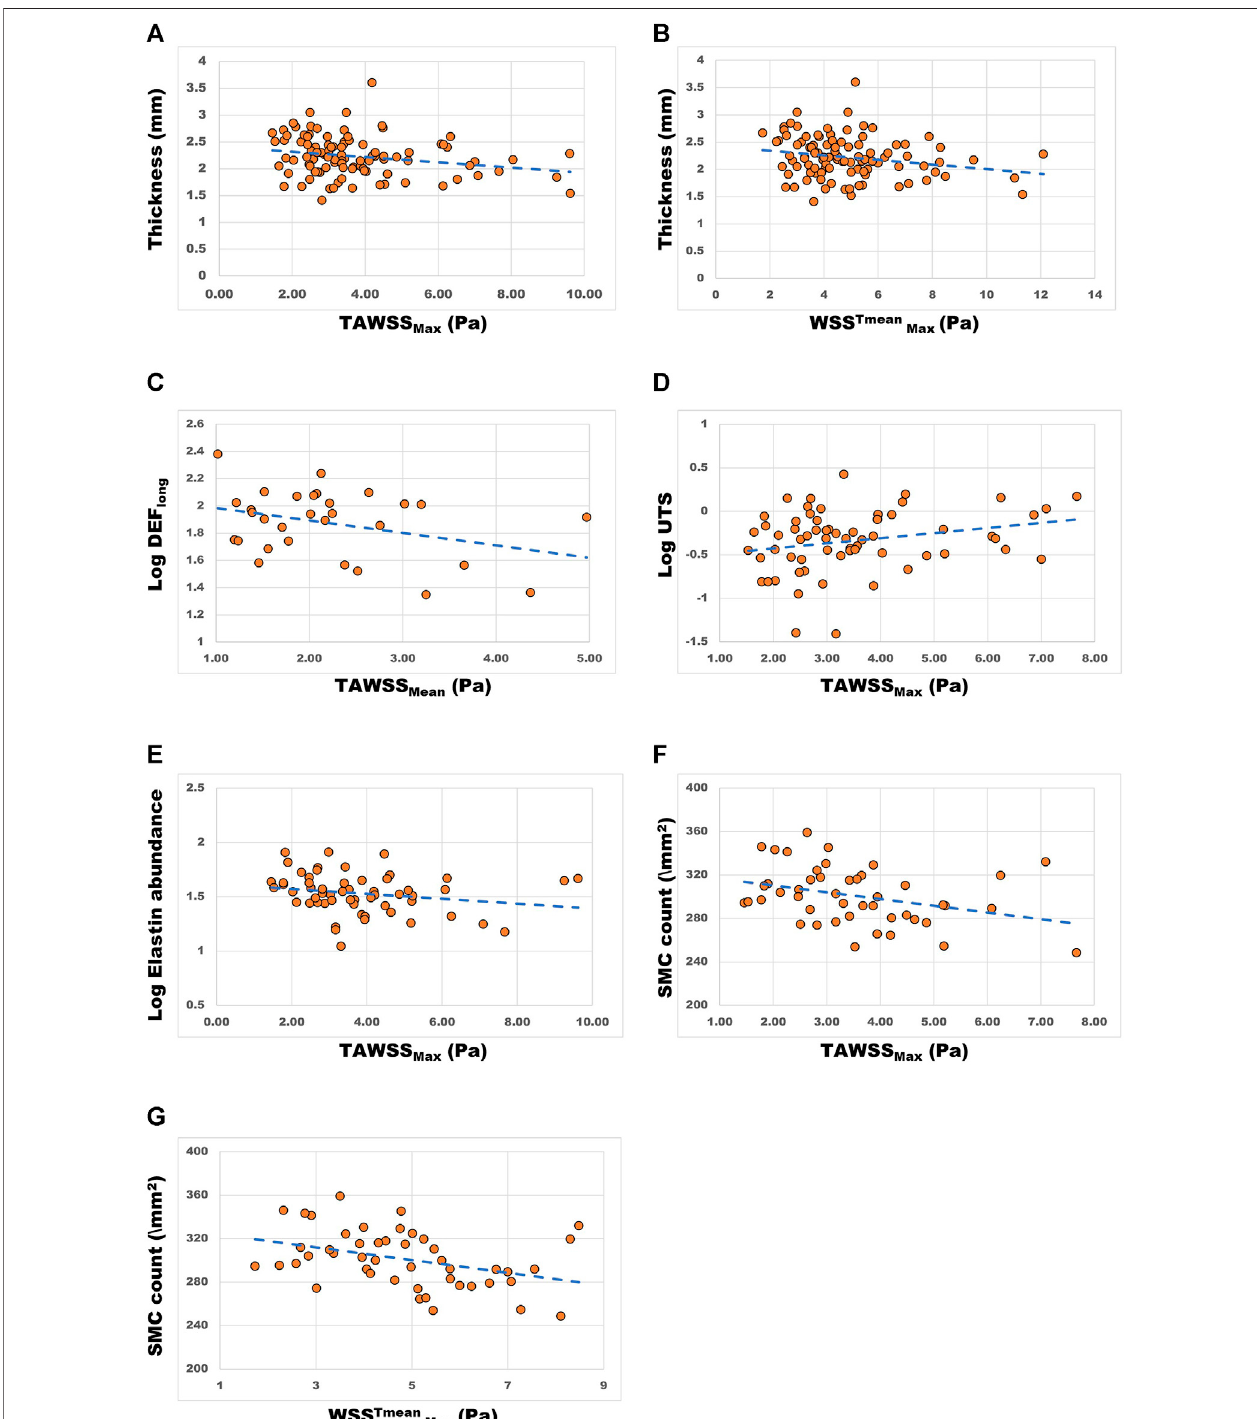
FIGURE 5 | Scatter plots and trendlines demonstrating the relationship between WSS parameters ( x -axes) and aortic wall material properties. (A) aortic wall thickness (mm) vs TAWSS max (Pa) and (B) WSS Tmean Max (Pa); (C) longitudinal dissection energy function (log 10 transformed, Log DEF long ) vs TAWSS mean (Pa); (D) ultimate tensile strength (log 10 transformed, Log UTS) vs TAWSS max (Pa); (E) Elastin abundance (log 10 (90-x) transformed) vs TAWSS max (Pa); (F) Smooth muscle cell (SMC) count (\mm 2 ) vs TAWSS max (Pa) and (G) WSS Tmean Max (Pa).